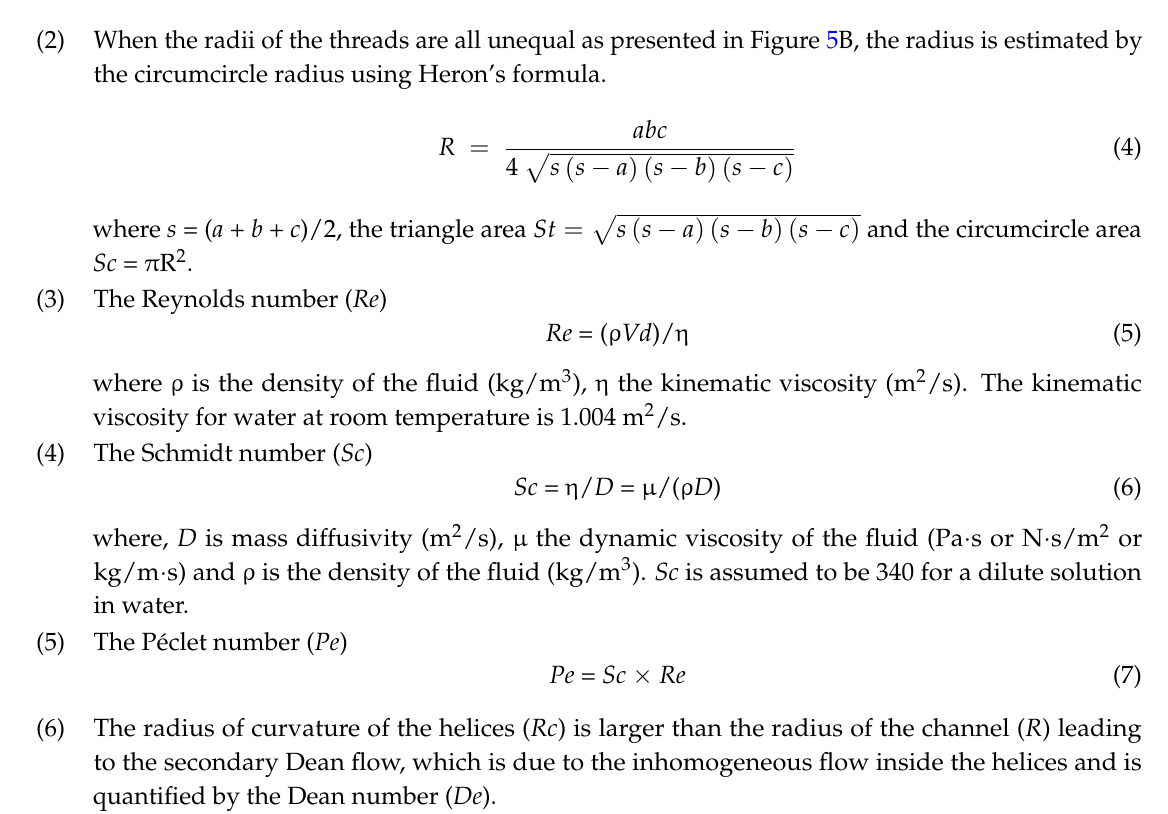
Figure 5. ( A ) The equivalent circular diameter calculated for the double helix ( d dh ). ( B ) Heron’s Formula used to calculate the radius, R , of the circumcircle used as an approximate radius of the triple helix.